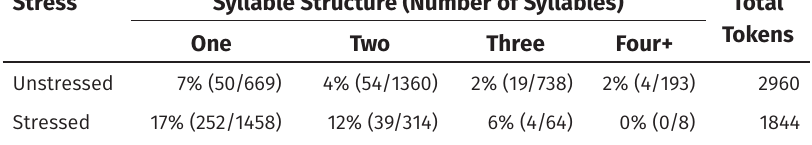
Table 3: Cross-tabulation of aspiration across syllable structure and